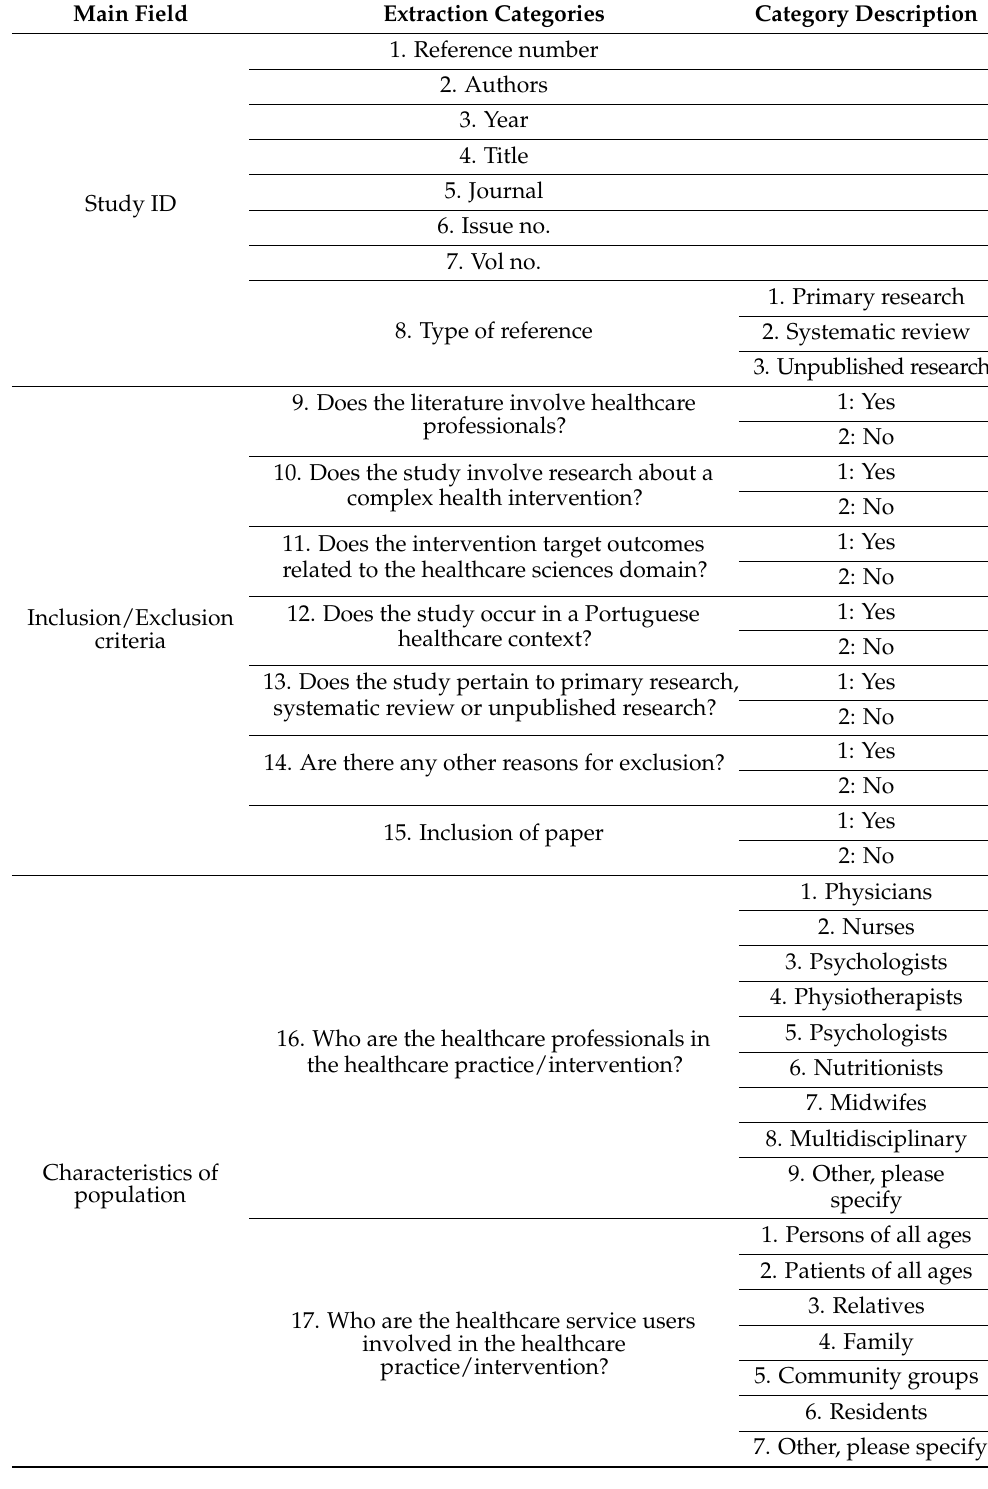
Table A2. Draft of data extraction